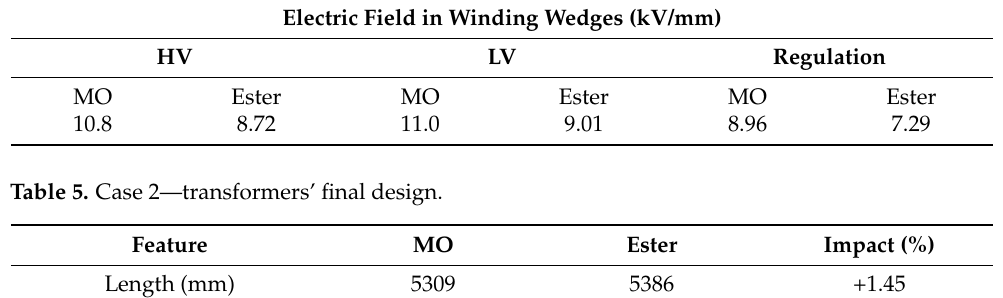
Table 4. Case 2—mineral oil versus ester: comparison.